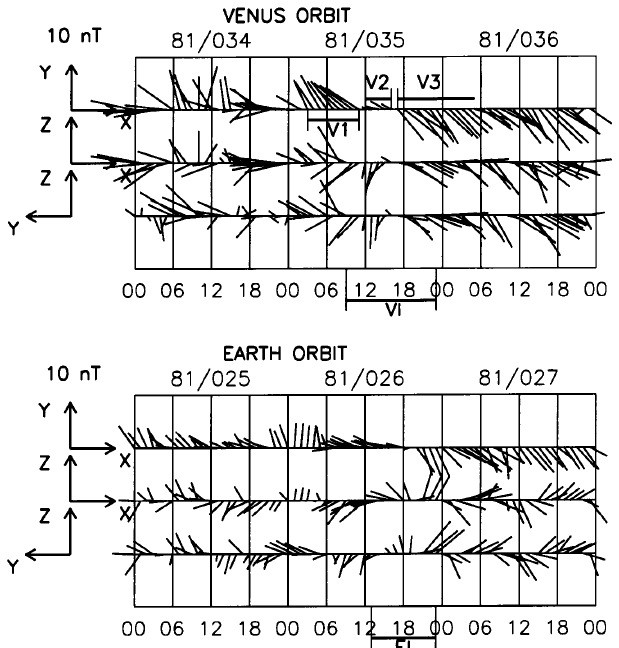
Fig. 4. IMF vector plots for sector boundary pair of no. 10 in Table 1. Single current sheets highly inclined out of the solar equatorial plane are observed both at Venus and Earth. However, a large time lag are found, suggesting the shift of the streamer